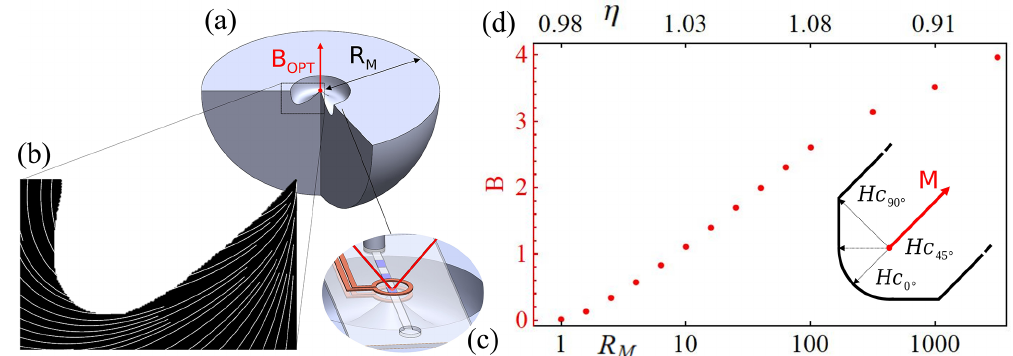
Figure 5. Panel (a) shows a section of the geometry (not drawn to scale) of a table magnet that creates an optimal field at the tip of its on-axis protrusion, indicated by a red dot. (b) Result of the topology optimisation for a magnet with diameter R M = 10 3 , with the magnetisation direction shown as white streamlines. (c) An example application for microfluidic NMR. (d) The dependence of the field intensity and coupling parameter η defined in Eq. (3), on the normalised (with respect to the distance above the plane being optimised) magnet radius R M . The inset on the right shows the phenomenological demagnetisation model for the magnetisation M used during optimisation. Further details on the model and its implementation as a regularisation are given in Sect. 3, in the magnetic material model and topology optimisation